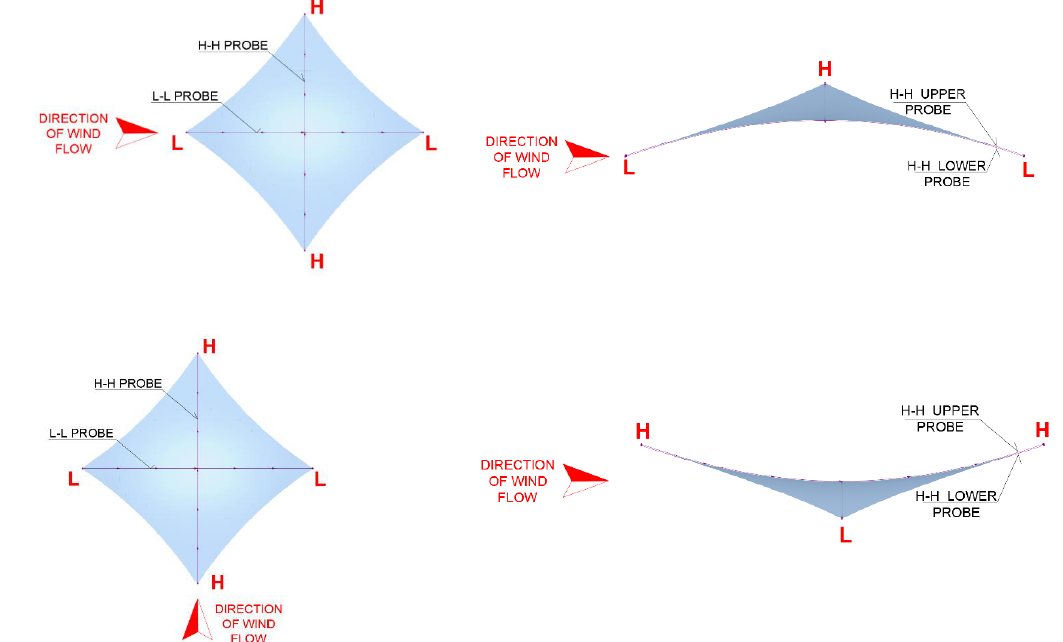
Figure 5. The placement of the probes in the structure and the directions of the wind.